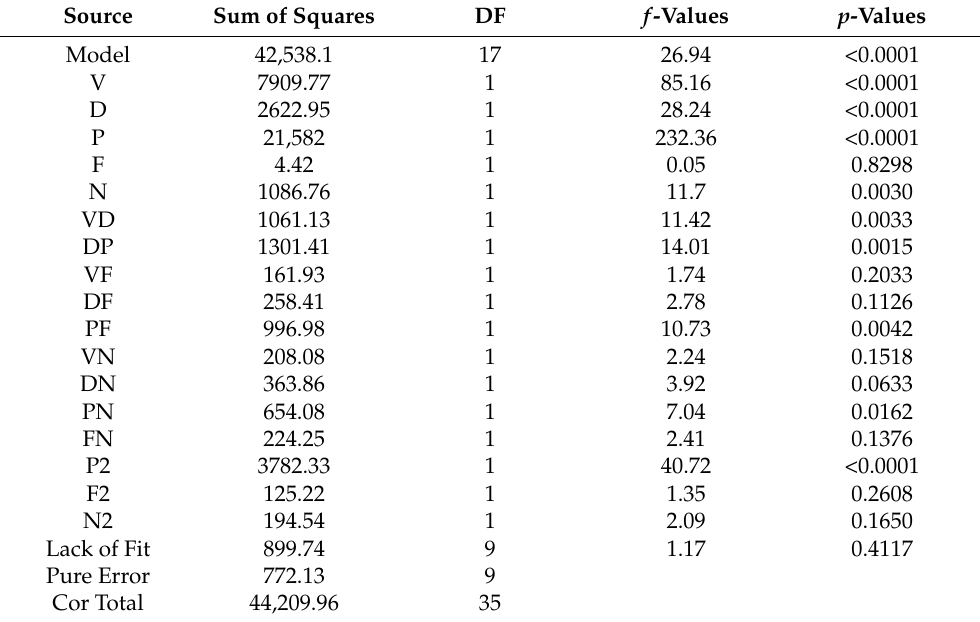
Lack of Fit 899.74 Pure Error 772.13 9 Cor Total 44,209.96 35 R 2 = 0.96, Adj. R 2 =